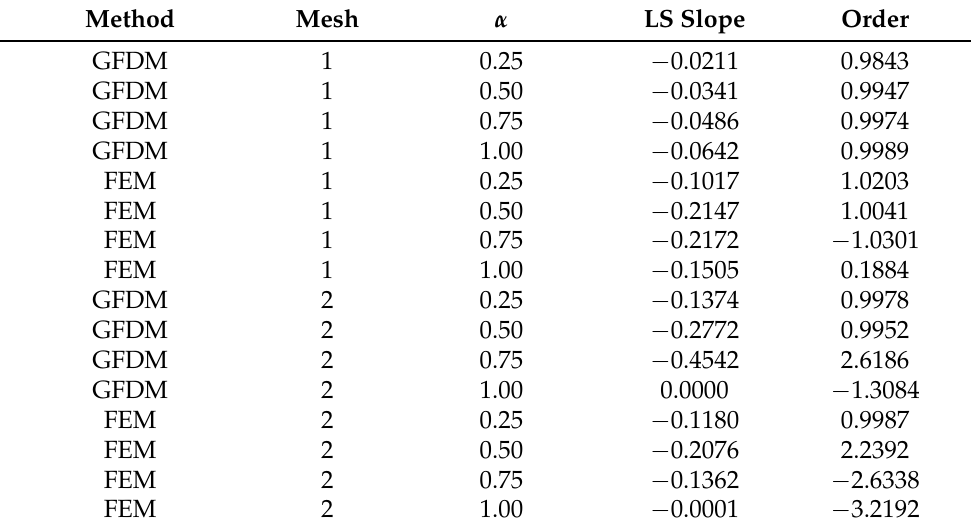
Table 3. Estimated order of convergence for each